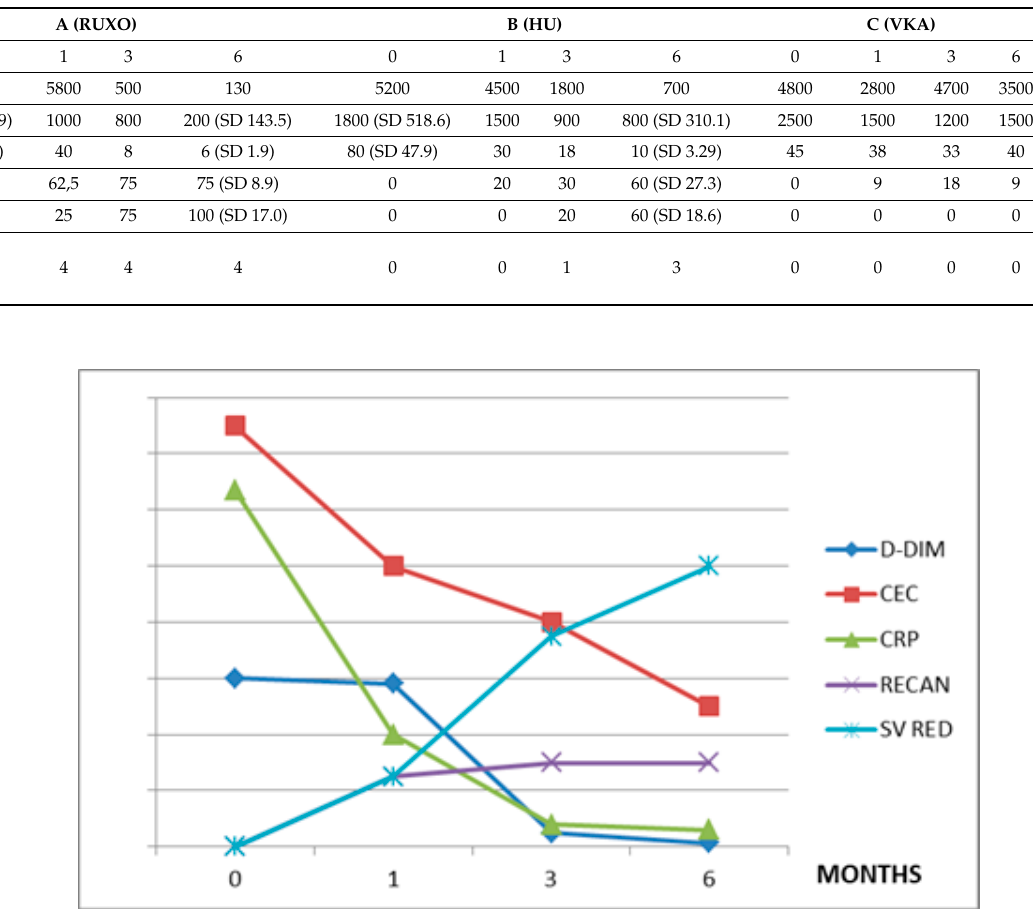
Figure 1. Ruxolitinib (A) group . CEC: circulating endothelial cells, CRP: C-reactive protein, D-DIM: d-dimers, RECAN: % of recanalization, SV: % of splenic volume reduction. Values on y-axis are in arbitrary measures.